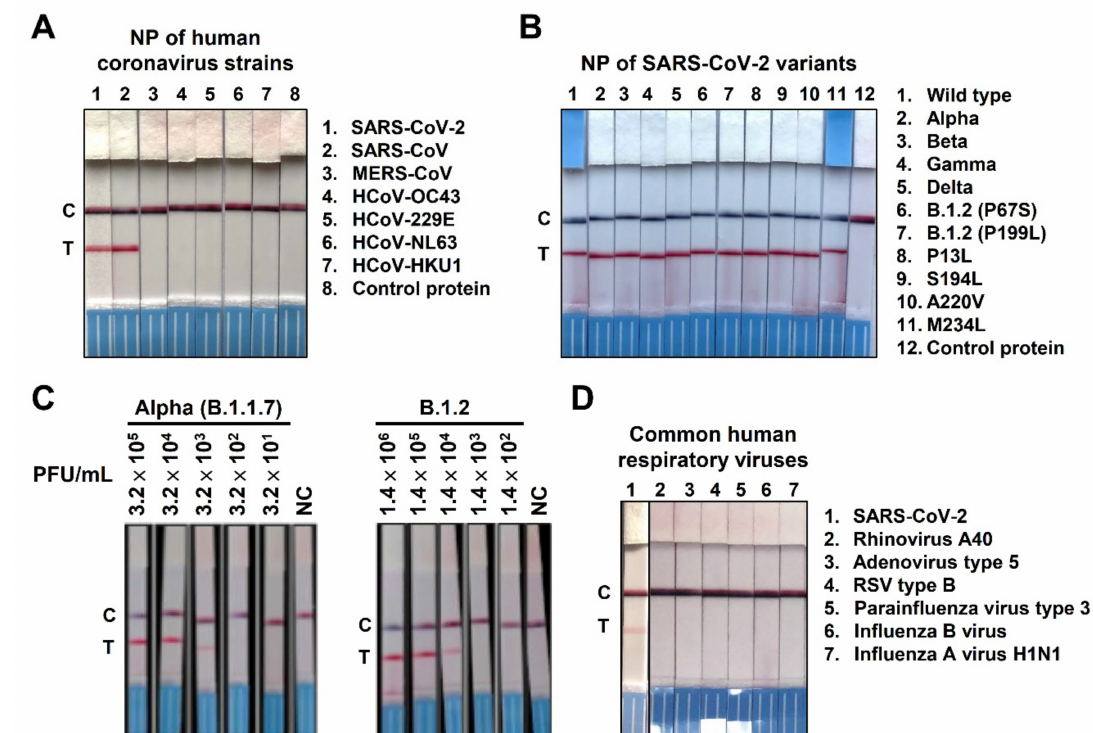
Figure 3. Specificity of NP mAb-40/7 LFIA strips. ( A ) Detection of viral NP of human coronavirus strains was performed by loading 10 ng of the indicated recombinant protein onto NP mAb-40/7 LFIA strips, followed by a 10-min reaction time. ( B ) The indicated recombinant SARS-CoV-2 NP variants were loaded onto NP mAb-40/7 LFIA strips at 1 ng. Mutations of D3L, R203K, G204R, and S235F have been identified in lineage B.1.1.7 (lane 2). A mutation of T205I was reported in lineage B.1.351 (lane 3); P80R was identified in lineage P.1 (lane 4); and D63G, R203M, D377Y, and R385K were found in lineage B.1.617.2 (lane 5). NC indicates the negative control. ( C ) NP mAb-40/7 LFIA strips were used to detect clinically identified alpha variant lineage B.1.1.7 and epsilon variant B.1.2 by loading the indicated viral titer (PFU/mL). NC indicates the negative control. ( D ) Several respiratory associated viruses were not detected by NP mAb-40/7 LFIA strips. SARS-CoV-2 served as a positive control (lane 1). The detecting concentration of the indicated viruses was 10 5 copies/reaction of SARS-CoV-2, adenovirus type 5, rhinoviruses A40, respiratory syncytial virus type B1, parainfluenza virus type 3, and influenza A virus H1N1. Influenza B virus utilized 10 6 copies/reaction for